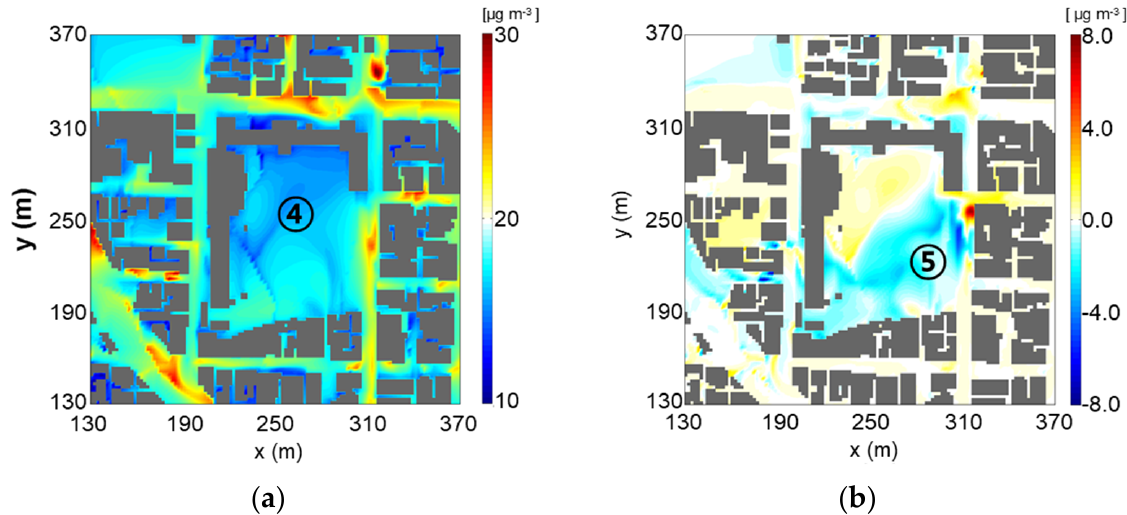
Figure 12. For the east–northeasterly inflow, ( a ) PM 2.5 concentration and ( b ) difference in PM 2.5 concentration between the T4M case and the CNTL case at 1 m above the ground.